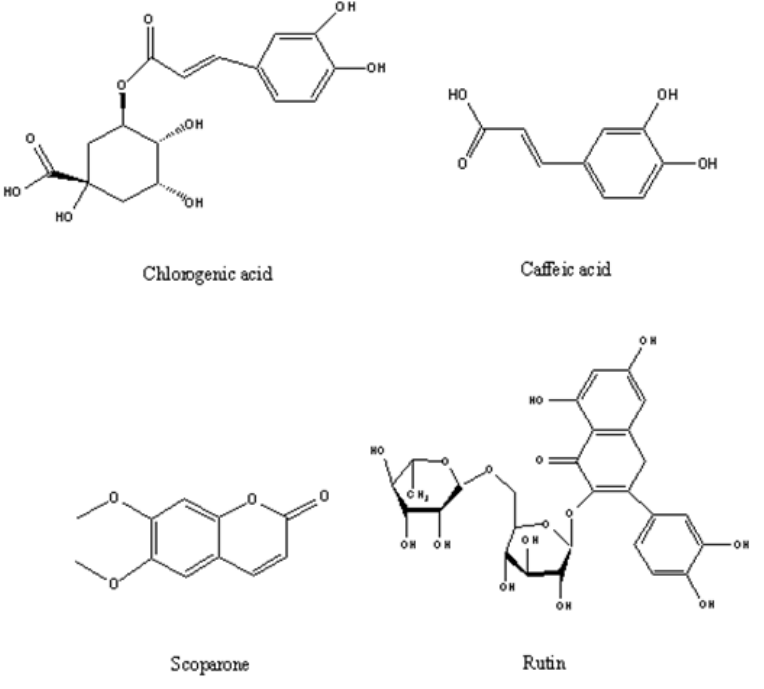
Figure 1. The chemical structures of the four target compounds.